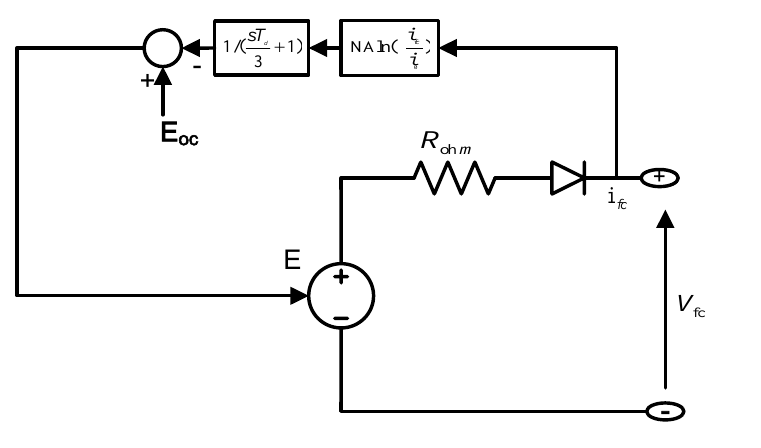
Figure 8. FCE principle model.